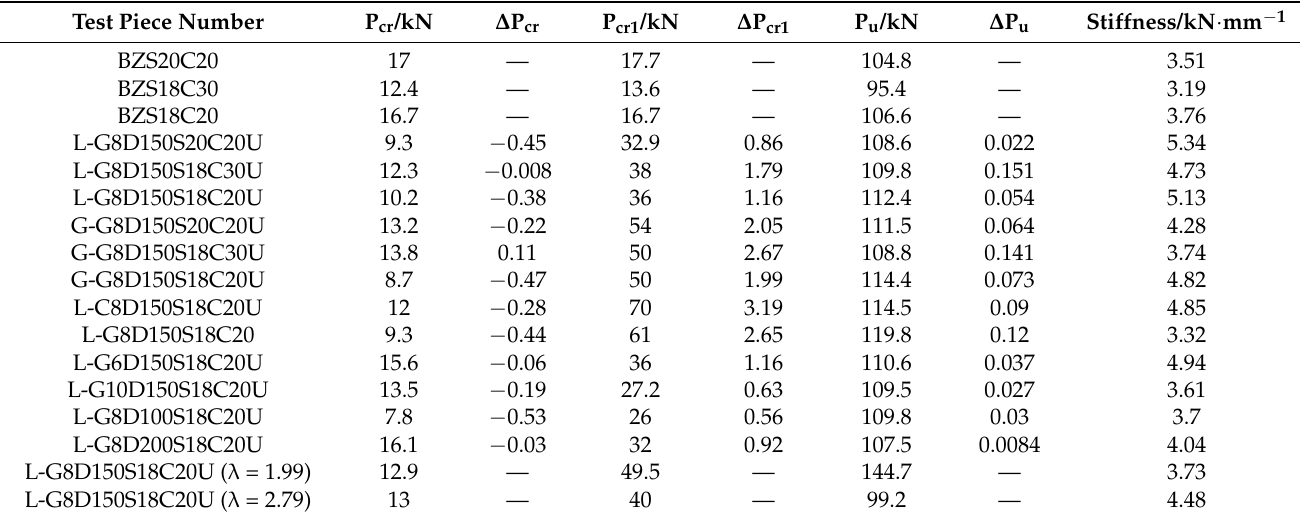
Table 7. Characteristic load of beam